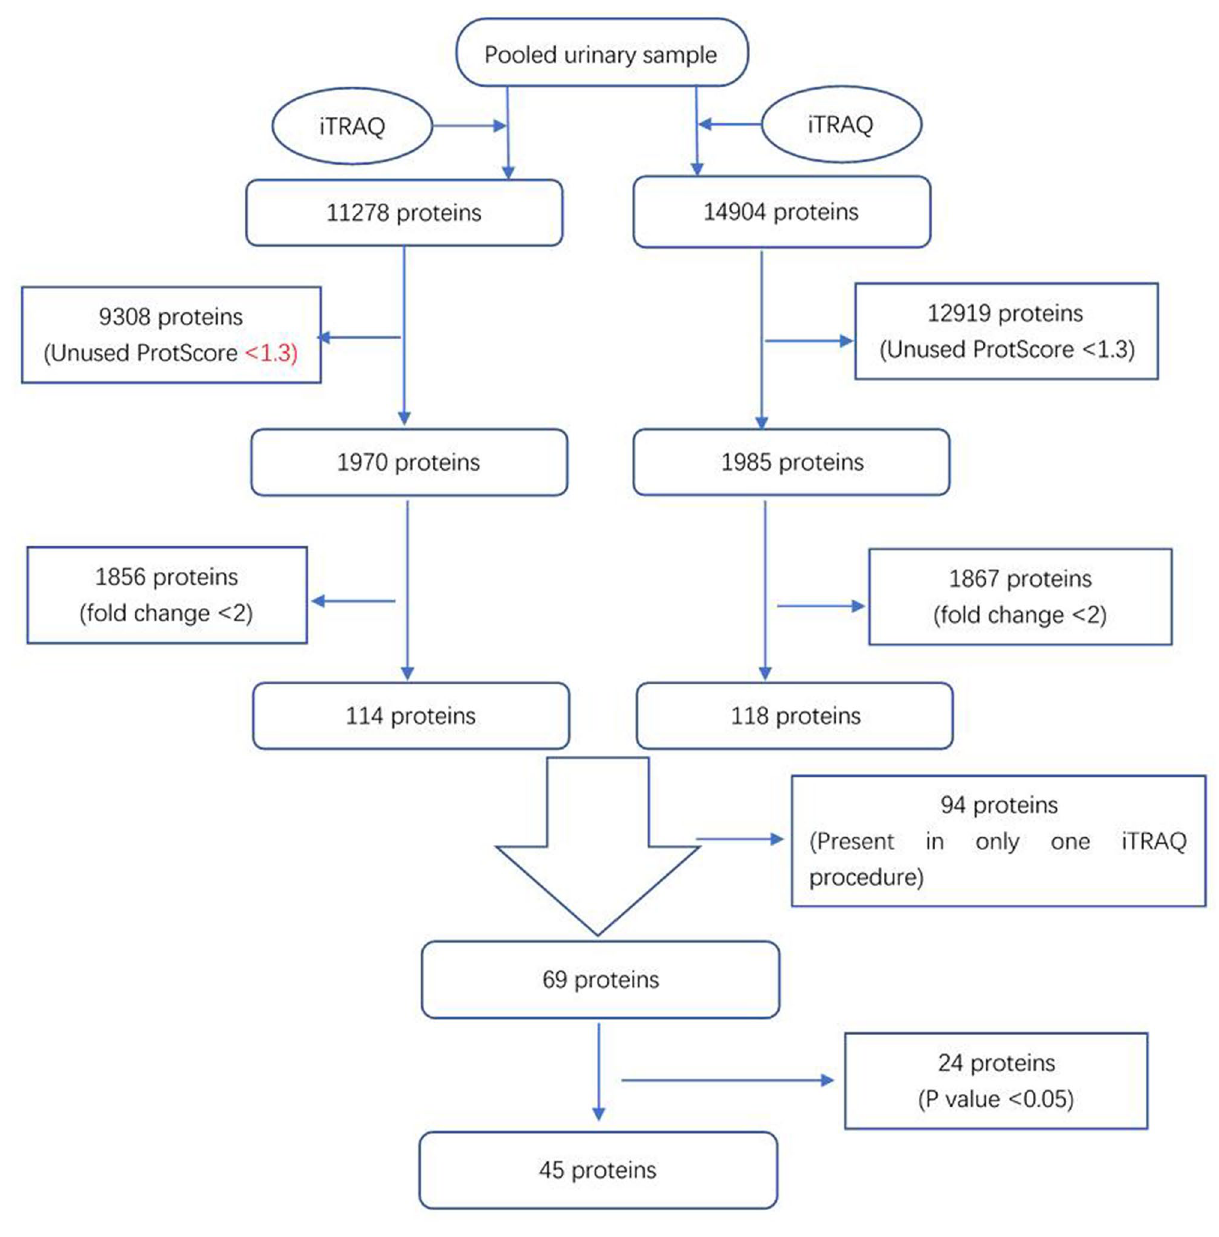
Figure 1. Flow chart of protein